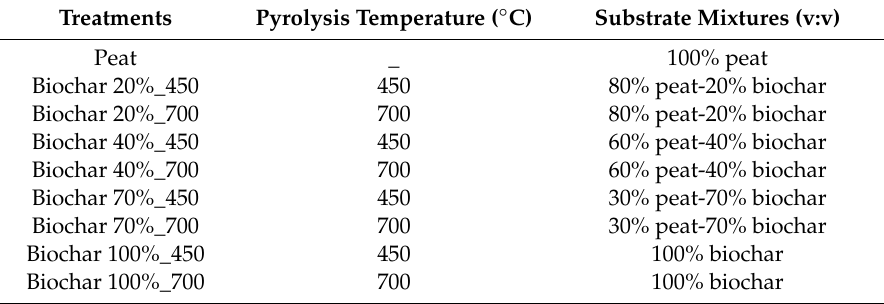
Table 1. Growing substrates tested for a soilless curly endive cultivation in a protected environment.